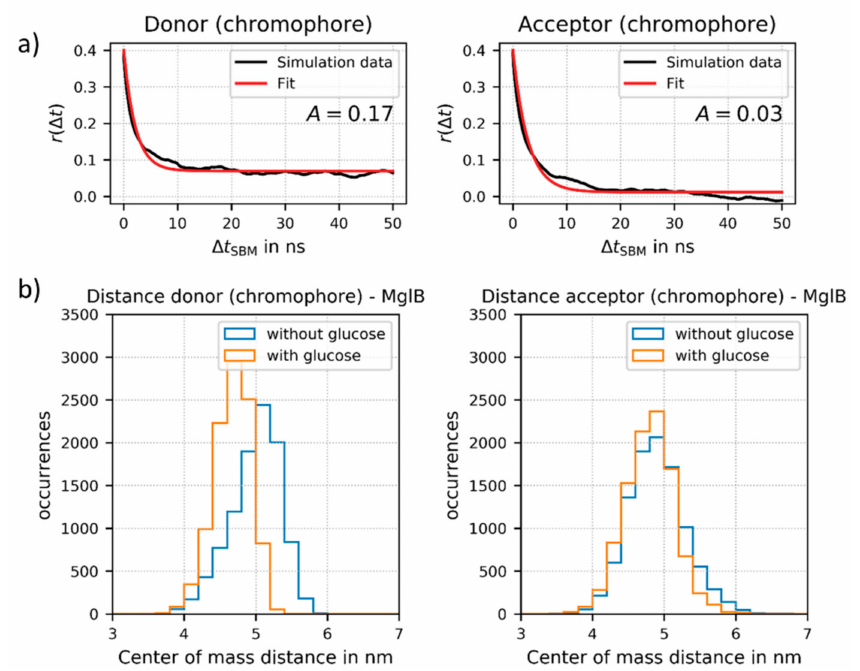
Figure 4. ( a ) Fits of the fluorescence anisotropy r( ∆ t) as a function of time ∆ t SBM for the donor chromophore (as part of mTurquoise2) and for the acceptor chromophore (as part of Venus) attached to MglB (here in the glucose-bound state). The time ∆ t SBM is given in ns in the SBM simulation, which does not directly correspond to a physical time scale. The model function for the “wobbling-in-a cone” model (solid red) was fitted to r( ∆ t) values obtained from the simulation of sensor no. 2. The respective rotational correlation times on a physical time scale are in a time regime of 190–290 ns (further details see Supplementary Materials, Section S2). ( b ) Relative distance change upon glucose binding between the donor FP and the center of the MglB (left) and between the acceptor FP and the MglB (right), respectively. For the distance calculation we used the center of mass of the respective chromophore of the